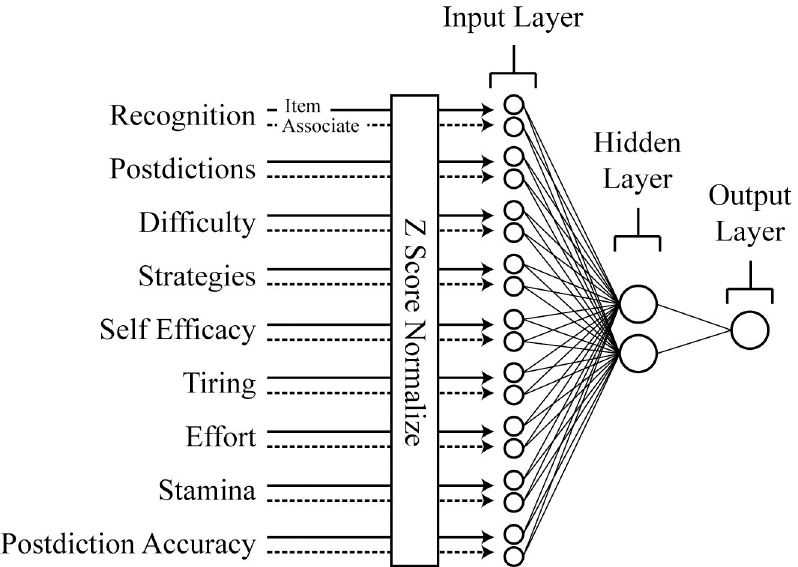
Fig 2. Architecture of the model employed. Recognition performance and the seven metacognitive variables were Z- score normalized and these scores were used as input activations in the input layer of the model. The hidden layer contained two units, and the output layer was made up of a single output unit. The network was trained to respond with an activation of 1 in the output unit when presented with an older adult’s data and -1 if presented with a younger adult’s